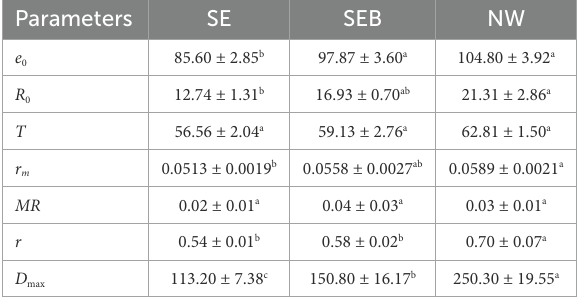
TABLE 2 The multiple comparisons of life history and population growth parameters in B. calyciflorus among different